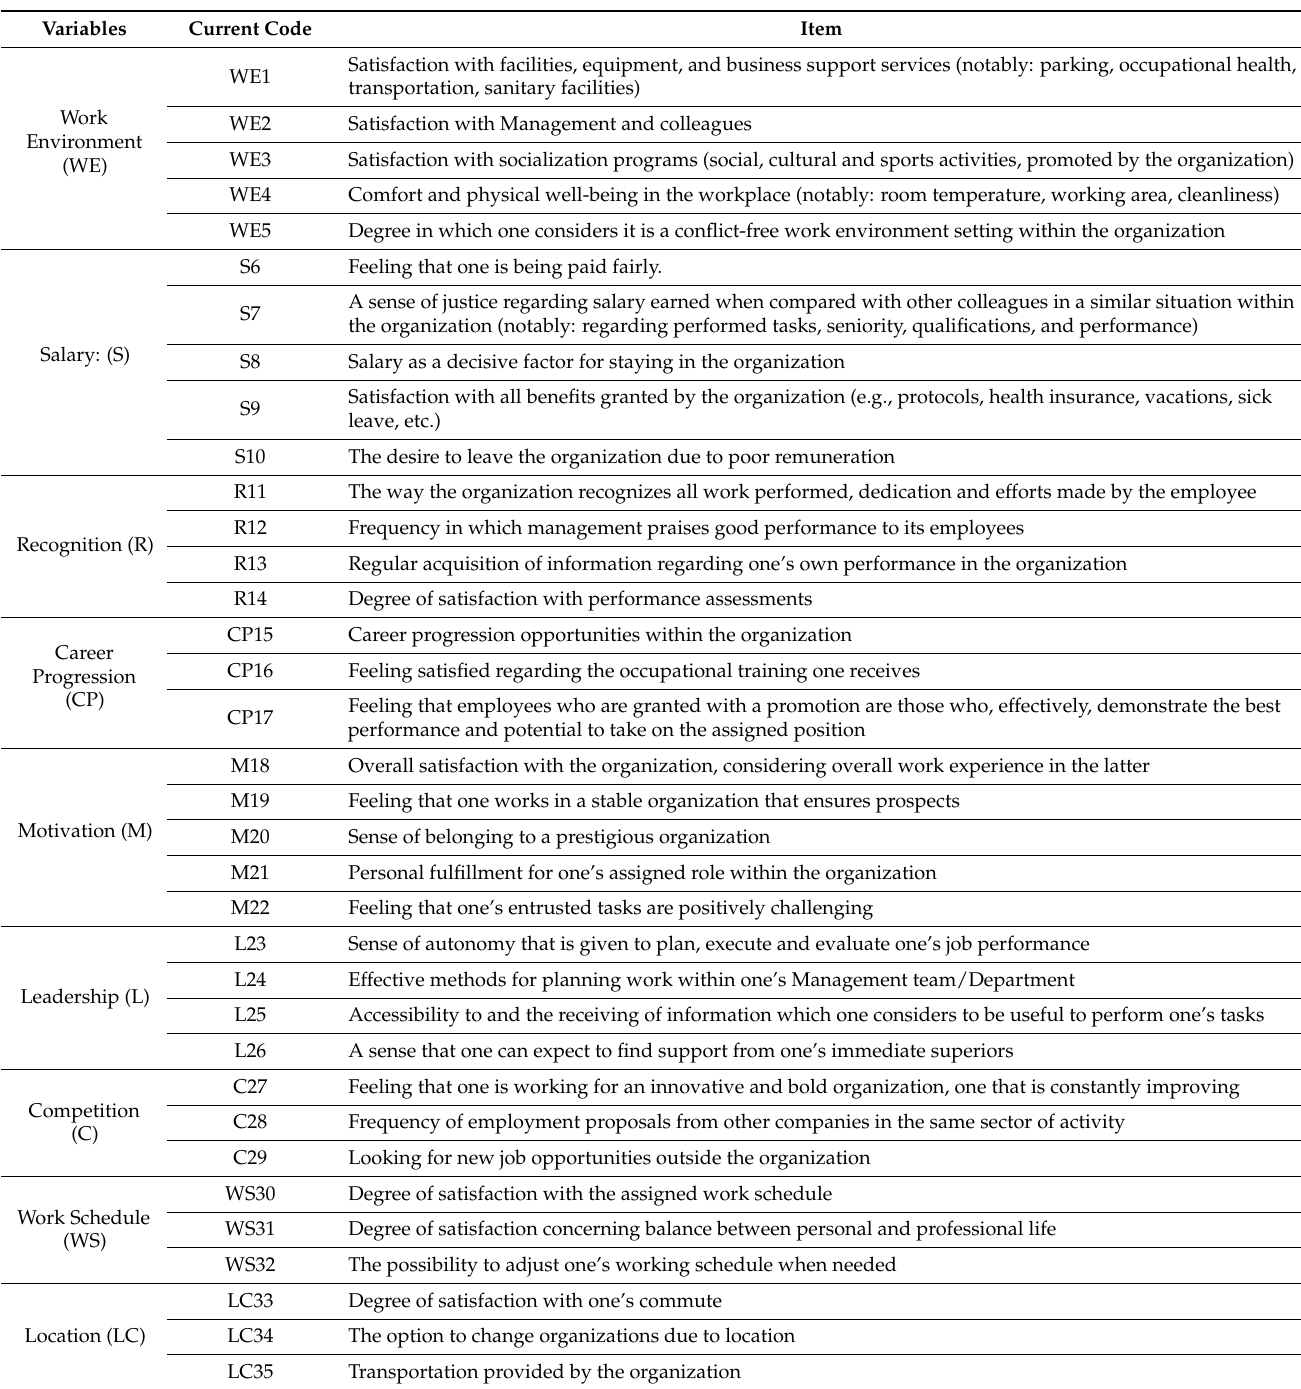
Table 3. Items of the Scale of Working Conditions for Measurement of Churning of Human